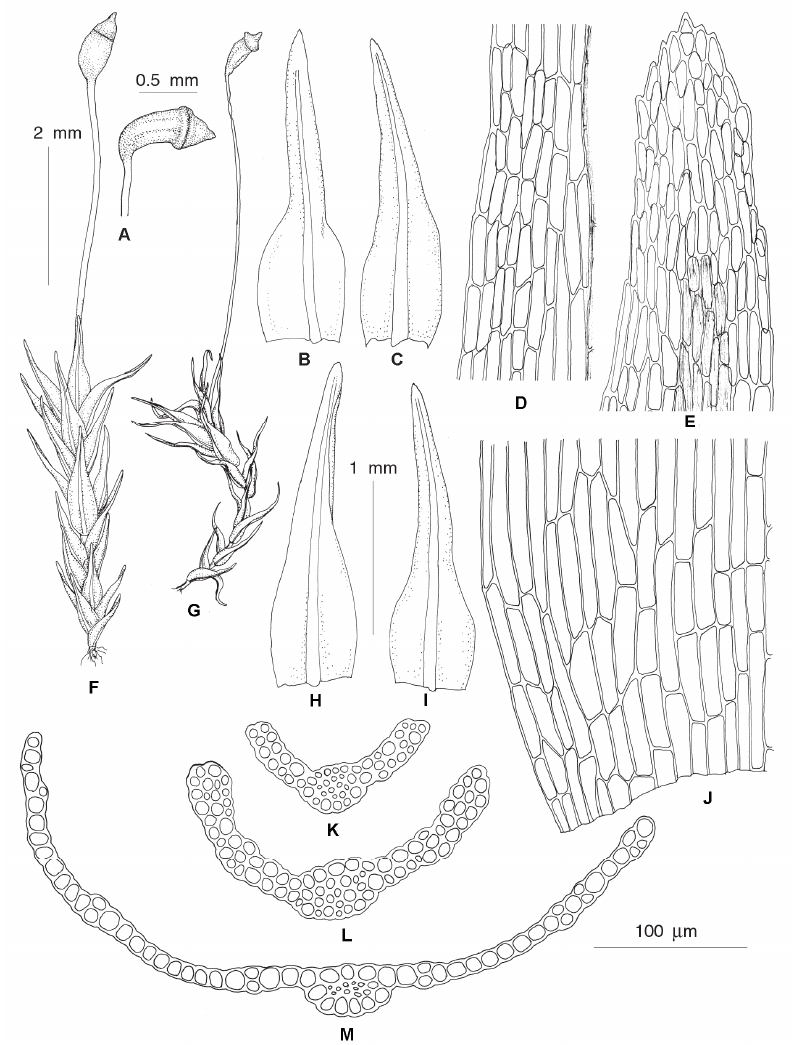
Figure 6. Line drawings of gametophyte and sporophyte of Protoaongstroemia sachalinensis (from: Holotype, isolate FDt122): ( A ) capsule, dry, ( B ) perichaetial leaf, ( C , H , I ) stem leaves, ( D ) mid-leaf cells, ( E ) upper-leaf cells, ( F ) view of fertile plant, wet, ( G ) fertile plant, dry, ( J ) basal leaf cells, ( K – M ) leaf transverse sections. Scale bars: 2 mm for ( F , G ); 1 mm for ( B , C , H , I ); 0.5 mm for ( A ); 100 µ m for ( D , E , J – M ).